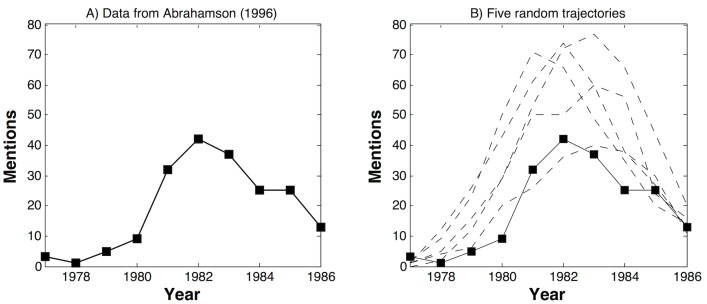
Abrahamson (1996)’s data: Comparison of the observed data and the predicted values from Poisson models using parameters from Table 2.